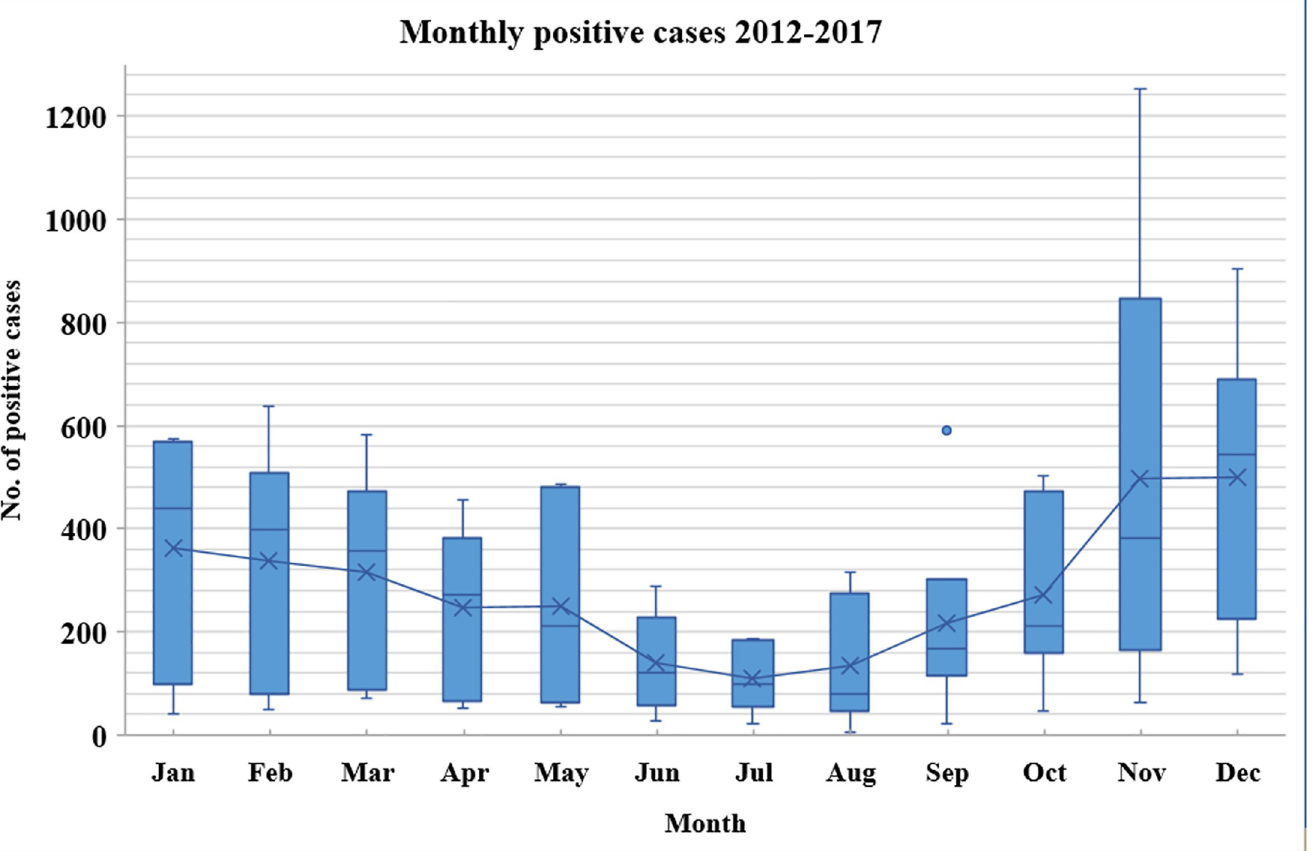
Fig 2. Monthly distribution of positive cases for at least one respiratory pathogen (2012–2017). The box plot shows the median mean differences. X: mean. Outer dots: outliers. Bars: standard deviation. The horizontal lines within boxes show the